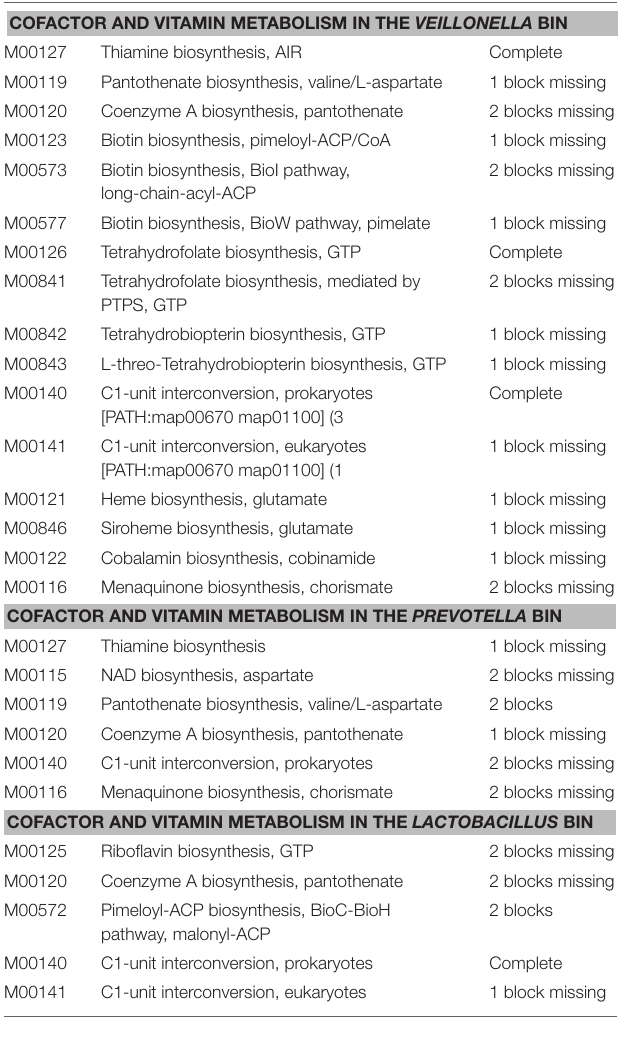
TABLE 5 | Presence of cofactor and vitamin metabolism pathways for all bacterial genomes as identified using KEGG database and BlastKoala. COFACTOR AND VITAMIN METABOLISM IN THE VEILLONELLA BIN